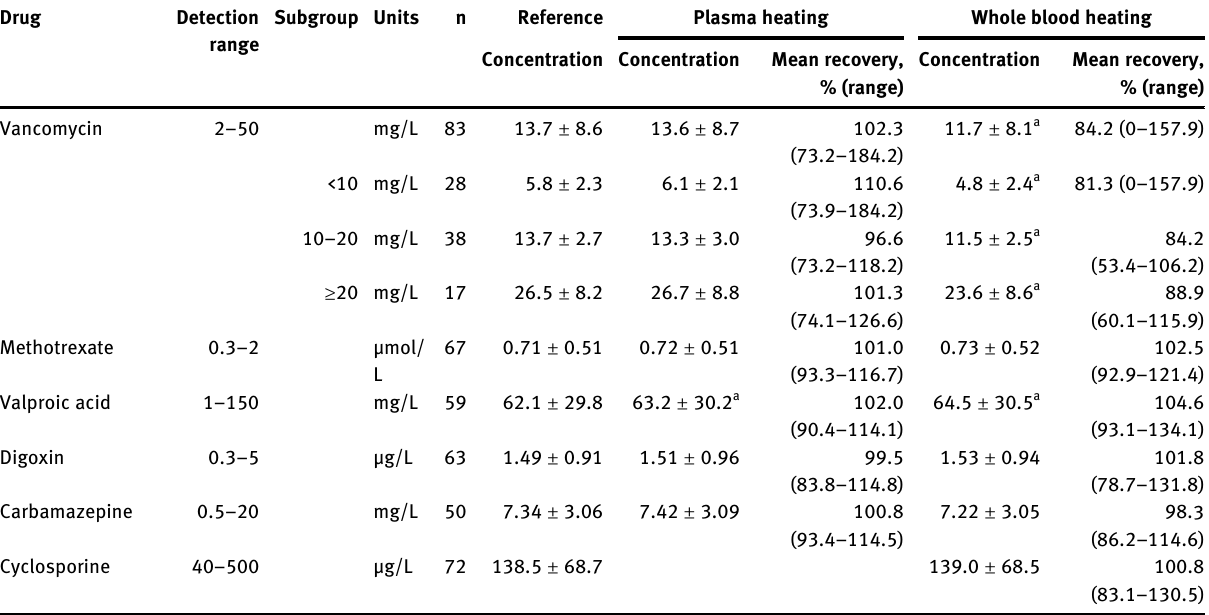
Table  : Effects of plasma heating and whole blood heating on therapeutic drugs.